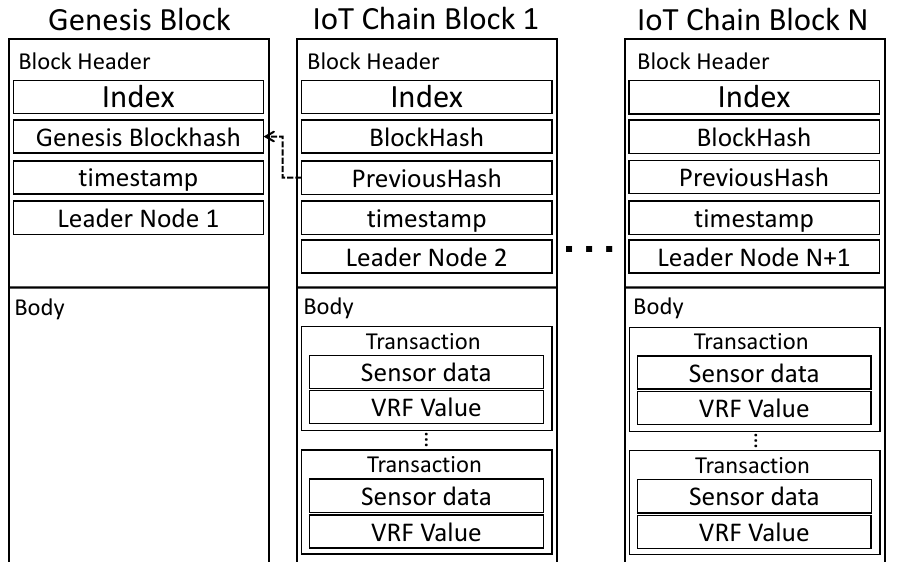
Figure 4. IoT-Chain block: block structure of